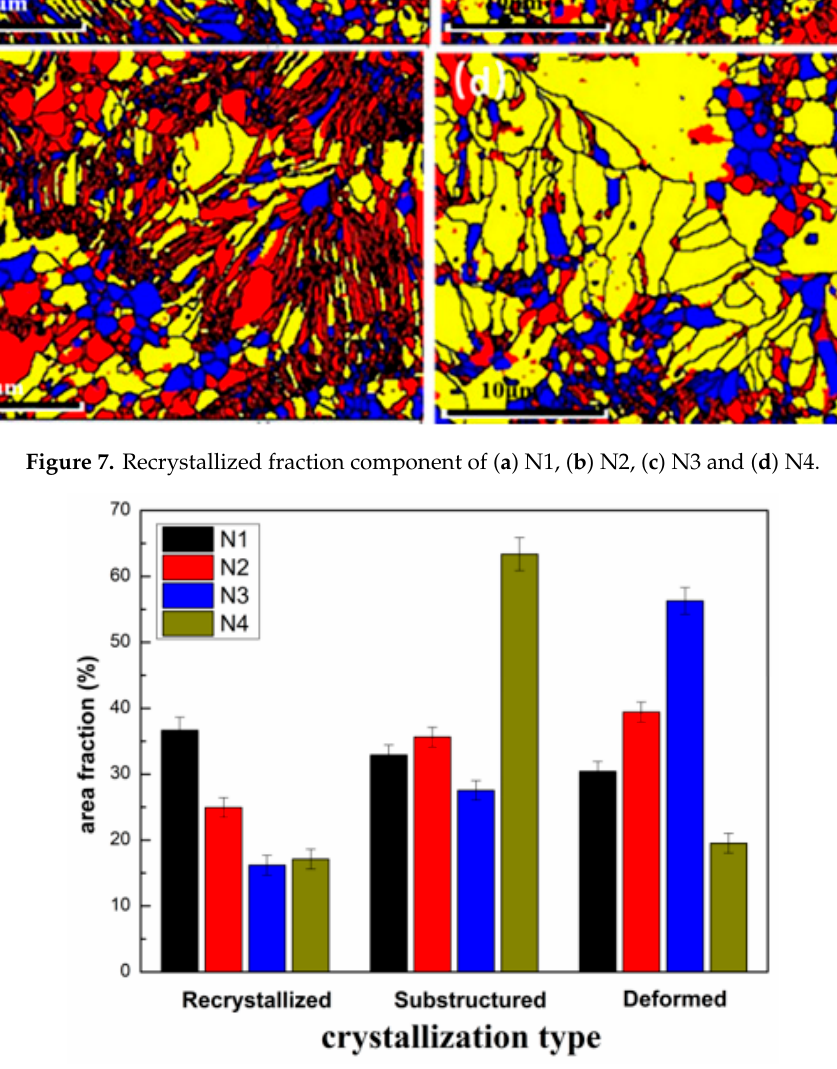
Figure 8. Area fraction of “recrystallized”, “substructured”, and “deformed” grains of four coatings.